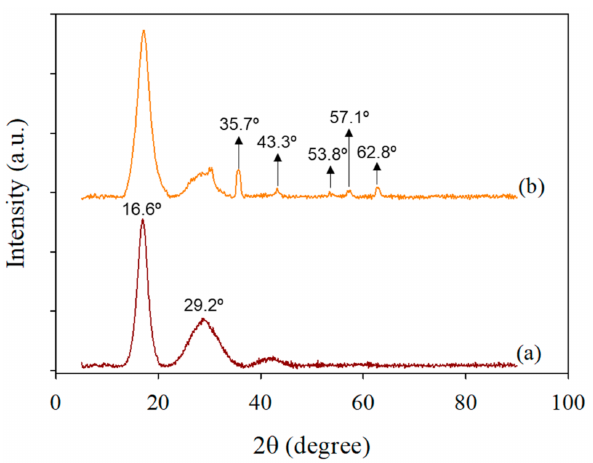
Figure 3. XRD results of composite nanofiber membranes: ( a ) PEI-AN and ( b )